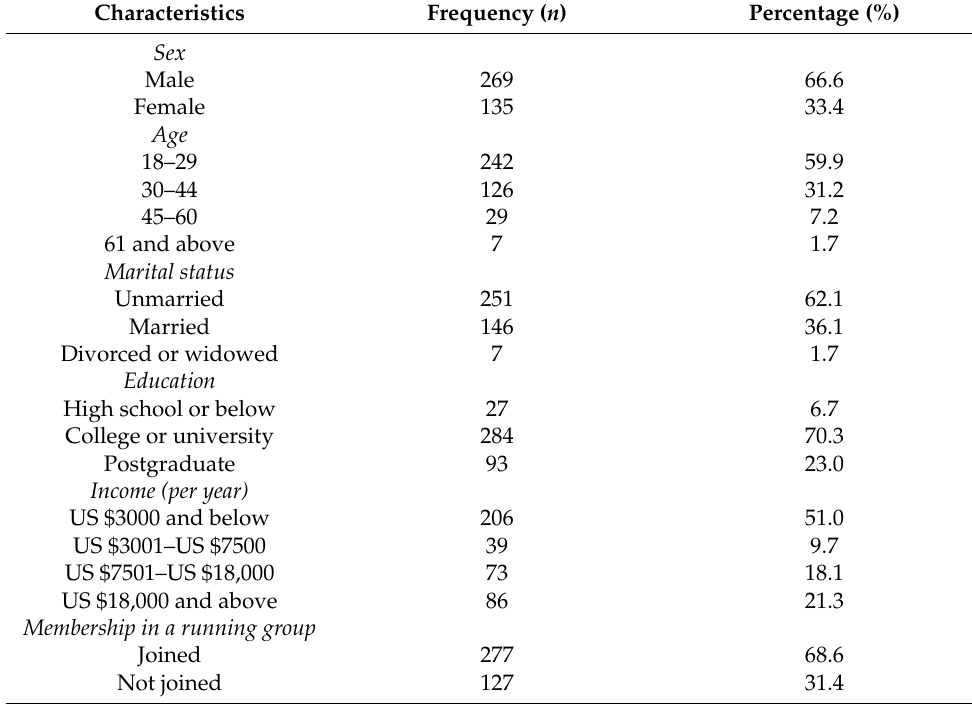
Table 1. Respondent’s profile ( n =